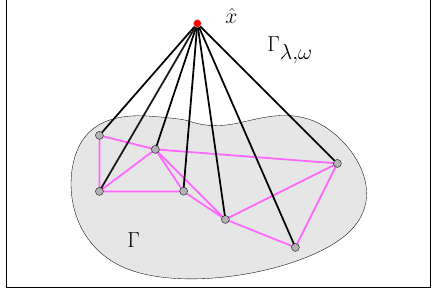
Figure 1: Host network.